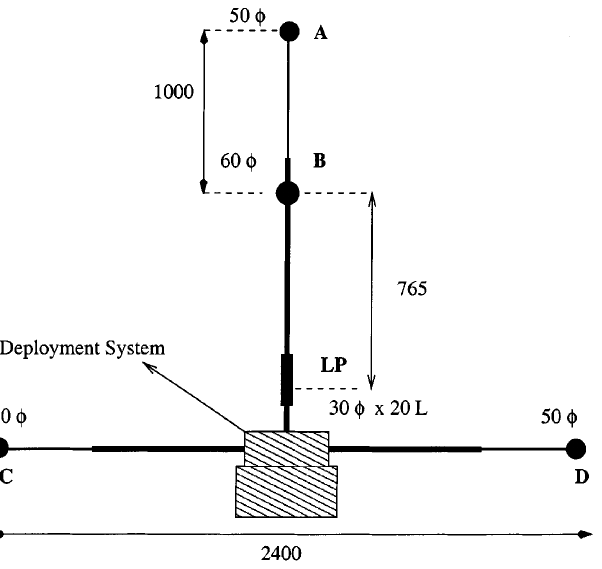
Fig. 1. Geometry of electric field and Langmuir probe sensors flown on the RH-560 rocket from SHAR